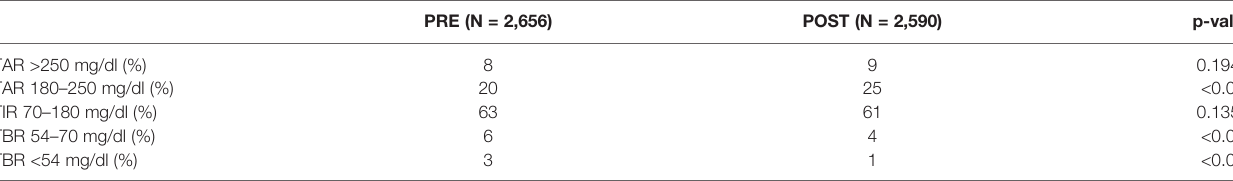
TABLE 1 | Glucometric data derived by fl ash glucose monitoring during treatment.